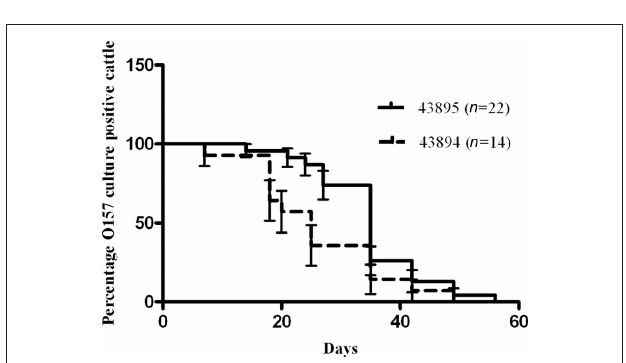
FigUrE 8 | Differential persistence of E. coli O157:H7 in cattle. Cattle were challenged with 43895 ( n = 22) or 43894 ( n = 14) using a single rectal application of 10 7 CFU of bacteria. Rectal swab samples from each animal was taken twice a week and cultured for E. coli O157:H7 until animals cleared the carriage of the bacteria. Percent survival indicated the percent of the cattle that were O157 culture positive. Survival time (duration of carriage) was defined as the number of days animals were cultured positive with E. coli O157:H7 and the P value was calculated by the Log-rank (Mantel–Cox)